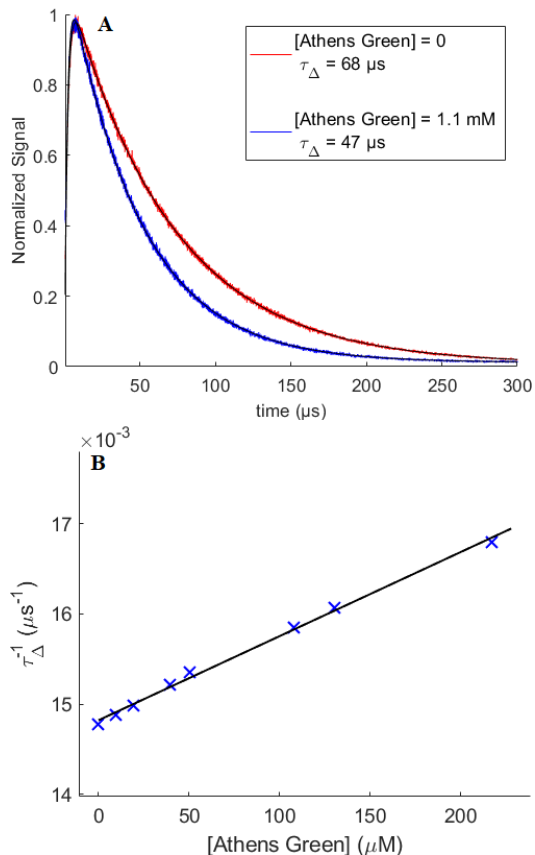
Figure 8. ( A ) Representative time-resolved 1275 nm O 2 (a 1 Δ g ) phosphorescence traces recorded upon 670 nm pulsed laser irradiation of AlPcS 4 in air-saturated D 2 O-PBS at pD = 7.8 in the presence of Athens Green, the concentration of which is shown in the legend. ( B ) The inverse lifetime of O 2 (a 1 Δ g ), τ Δ−1 , plotted as a function of the concentration of Athens Green, obtained from experiments such as those shown inFigure 8A. The solid black line is a linear fit to the data, the slope of which yields k total . The size of the symbols in Figure 8B represent the errors on each data point. Table 5. Rate constants for the interaction with O 2 (a 1 Δ g ) measured at two different pD values in air- saturated solutions. Compound pD = 7.8 pD = 5 k total